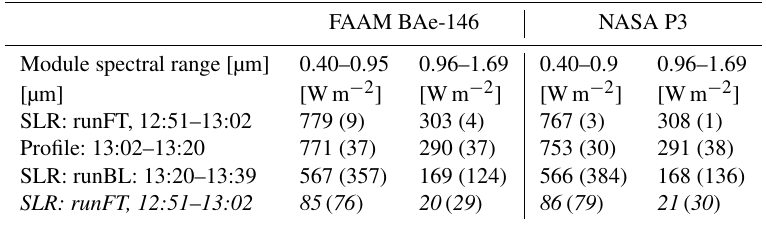
Table 7. The integrated fluxes derived from the SHIMS and SSFR instruments over the SHIMS module spectral ranges. The measurements in standard font represent downwelling irradiances, while those in italics represent upwelling irradiances. Values in brackets denote 2 standard